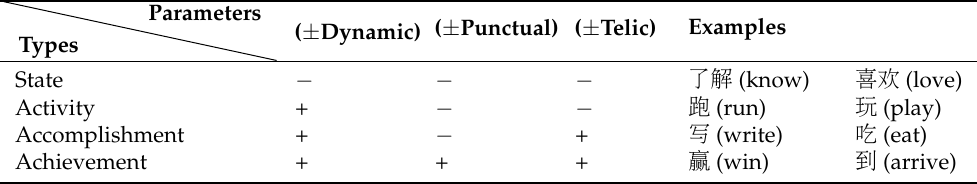
Table 2. Classification of lexical aspect of verbs in